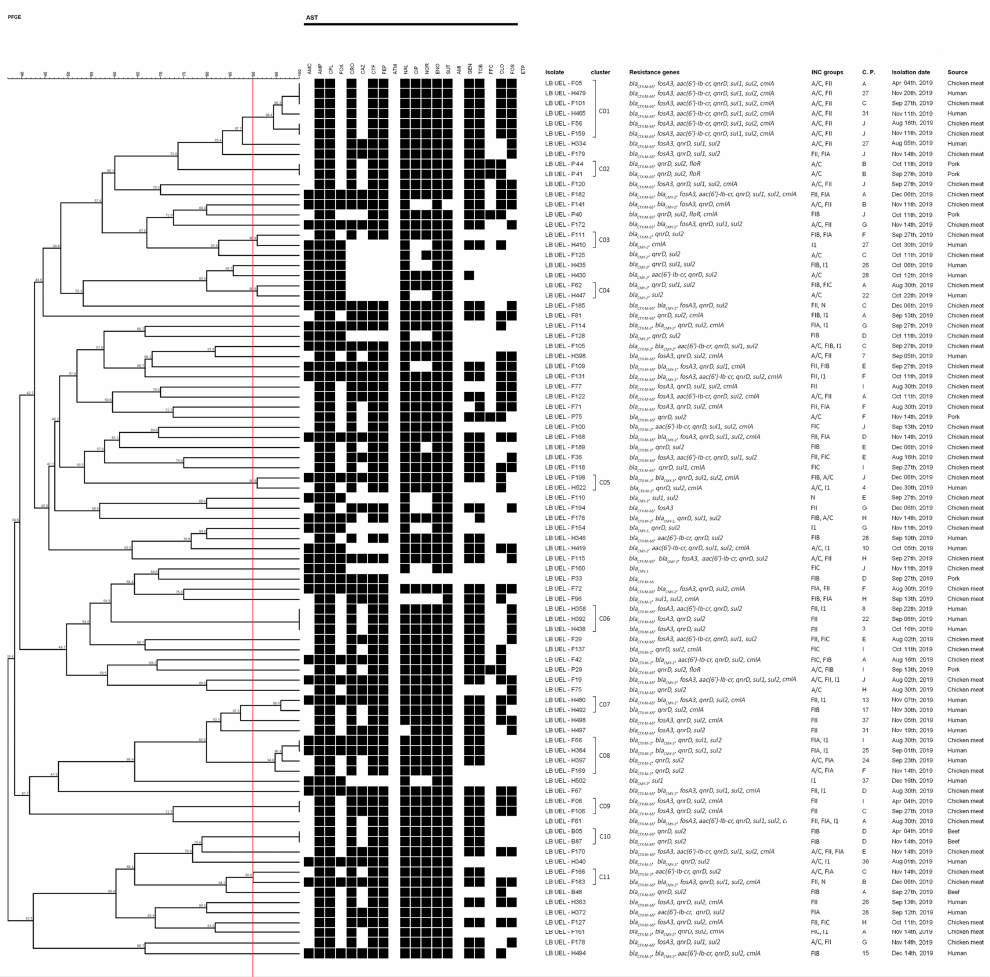
Figure 4. Dendrogram obtained from Not I-PFGE typing of the 87 P. mirabilis ESBL-AmpC producers. Dendrogram was constructed using optimization 0% and tolerance 1.5%. SXT: sulfamethoxa-